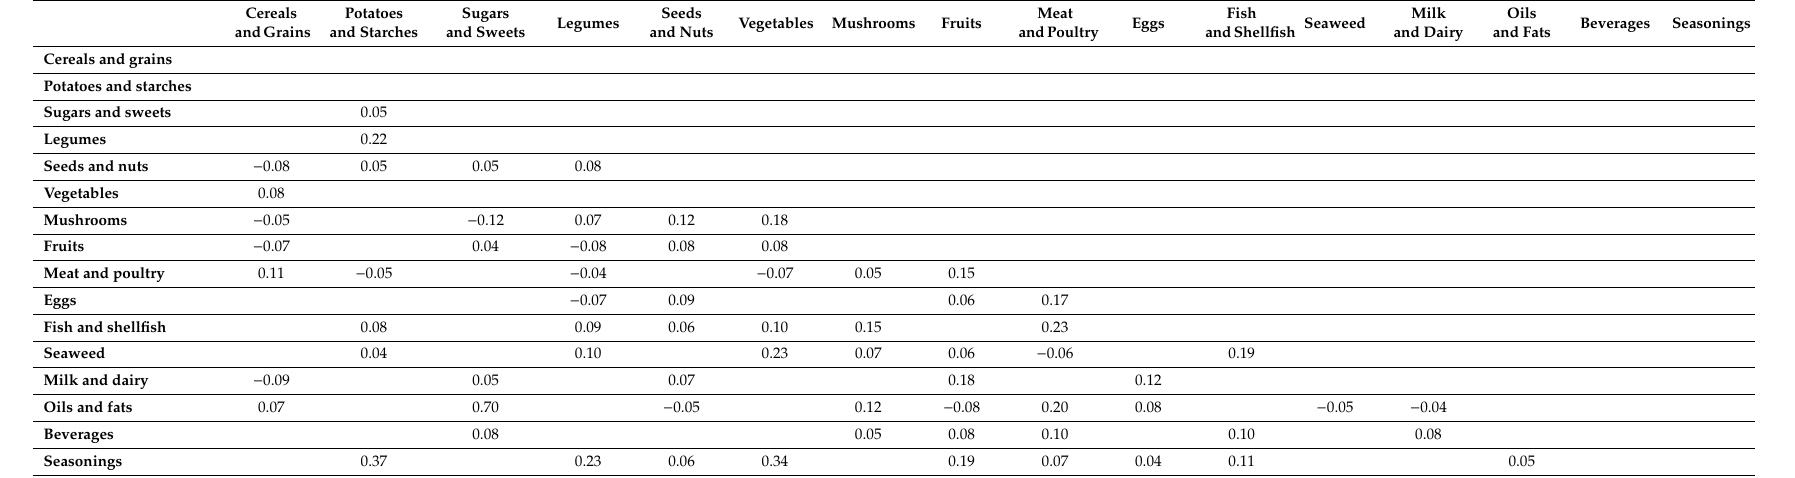
Table 1. Adjacency matrix for partial correlation of dietary intake of 16 food groups.